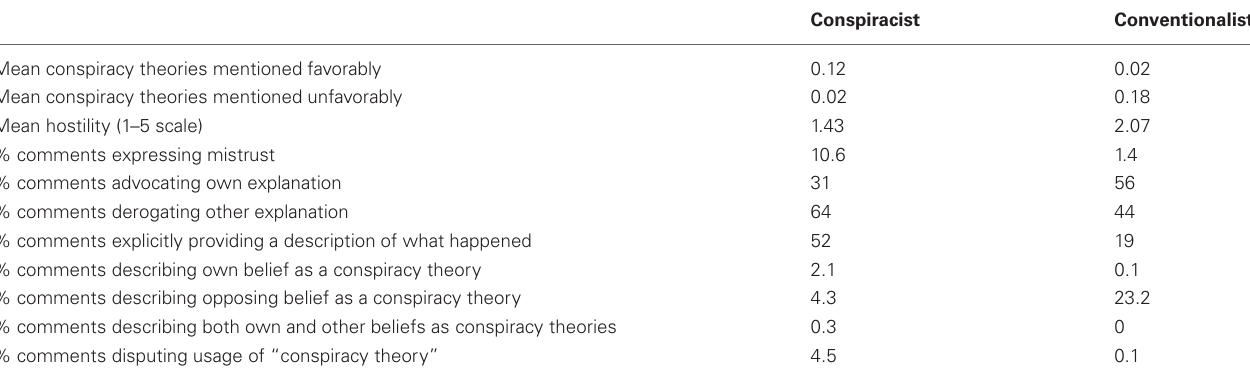
Table 1 | Rhetorical components of conspiracist and conventionalist